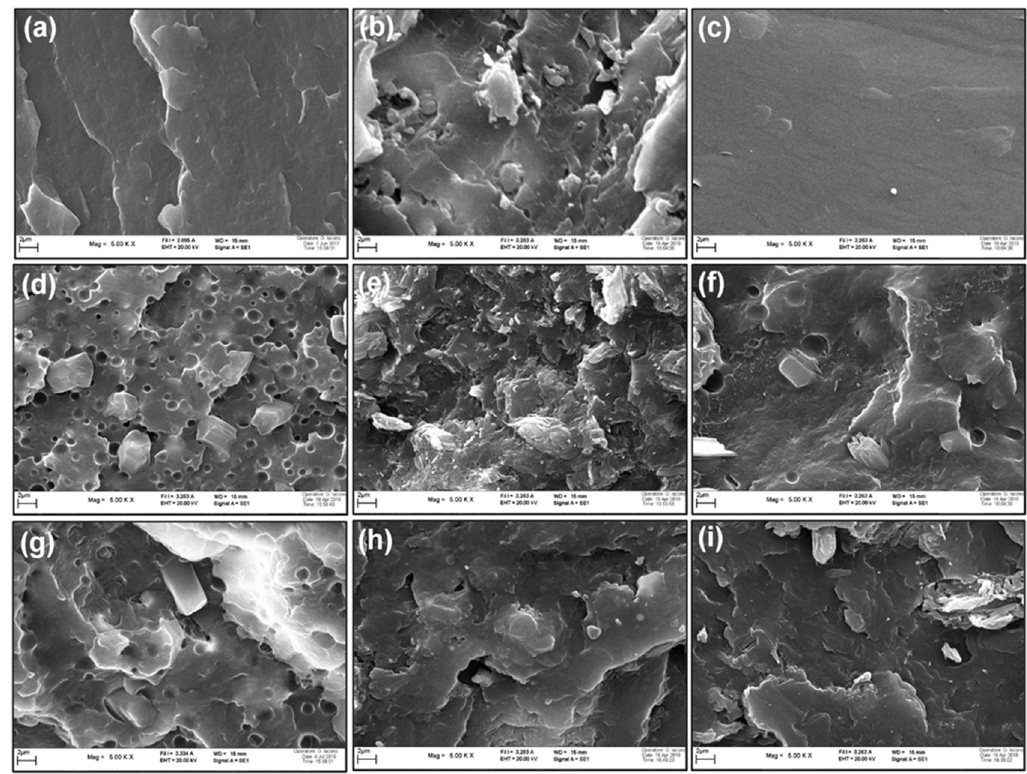
Figure 1. Scanning Electron Microscopy (SEM) micrograph of polyamide 11 (PA11) and its binary and ternary blends. ( a ) PA11; ( b ) PA 80 -LL 20 ; ( c ) PA 80 -DL 20 ; ( d ) PA 80 -ZnP 20 ; ( e ) PA 80 -AlP 20 ; ( f ) PA 80 -LL 10 -ZnP 10 ; ( g ) PA 80 -DL 10 -ZnP 10 ; ( h ) PA 80 -LL 10 -AlP 10 ; ( i ) PA 80 -DL 10 -AlP 10 at 5000× magnification.